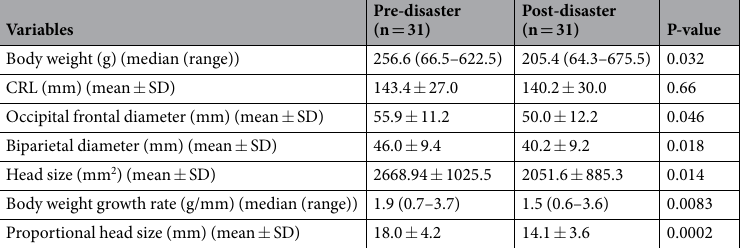
Table 3. Descriptive statistics for pre- and post-disaster monkey fetuses in Fukushima (n = 62).